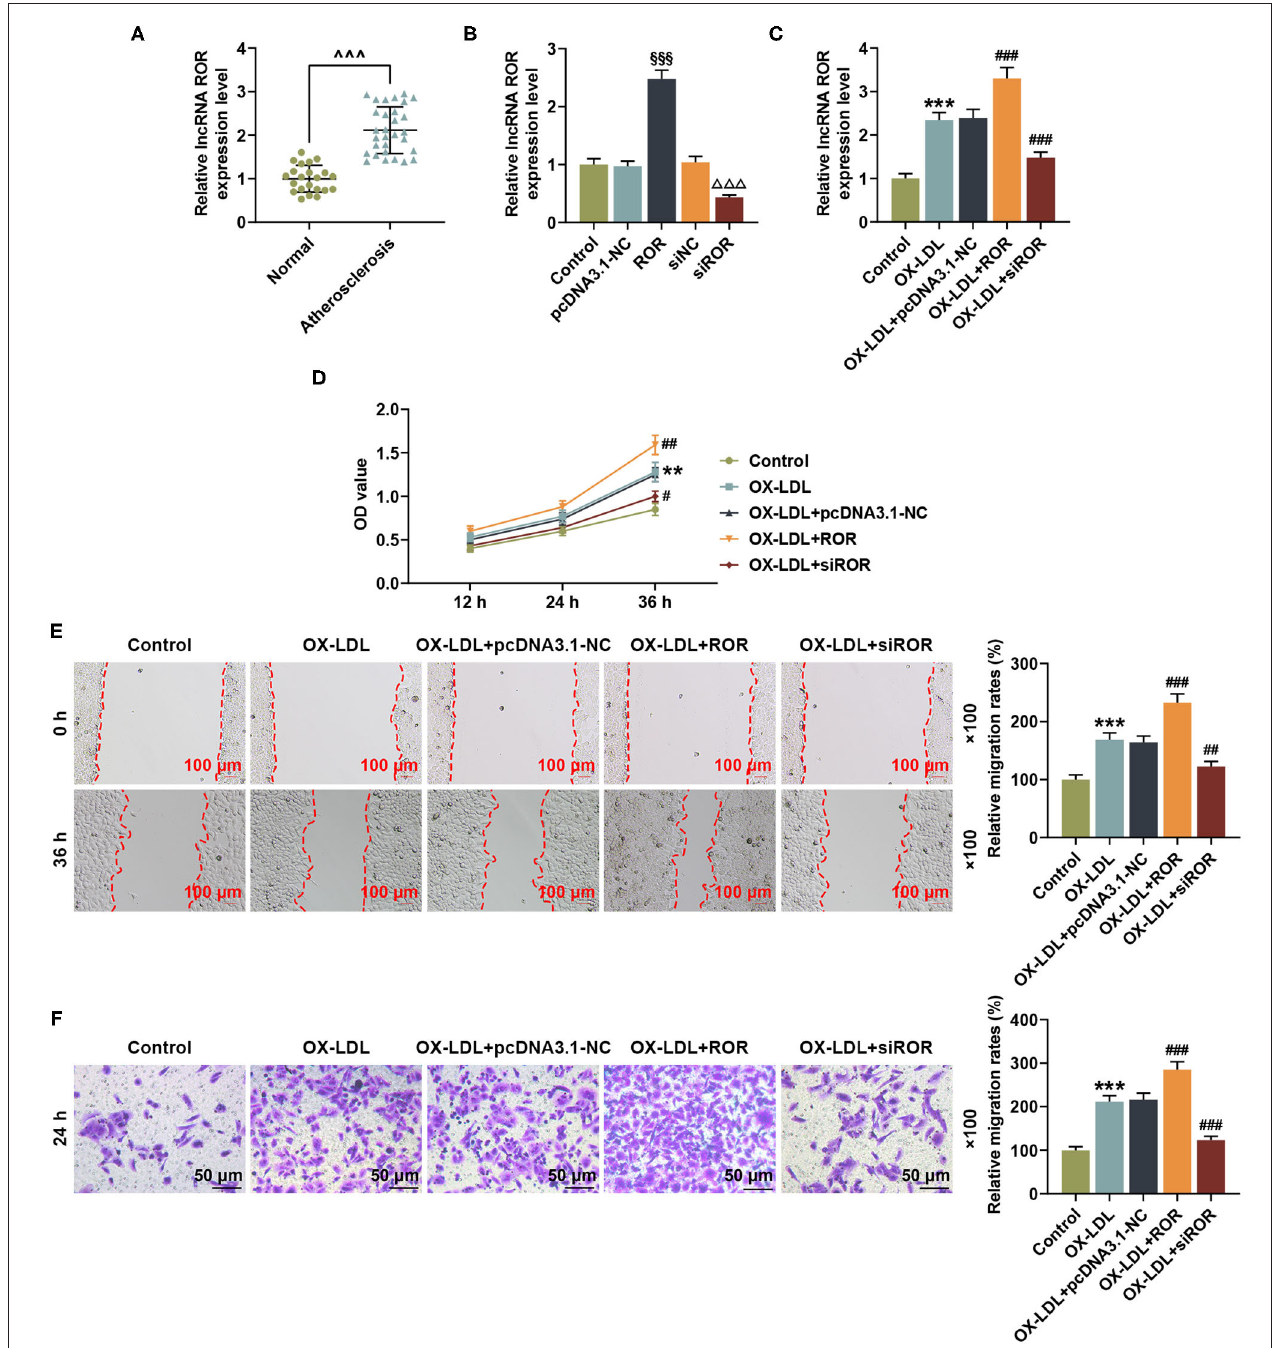
FIGURE 1 | lncRNA ROR expression was upregulated in AS and ox-LDL-treated HUVECs and affected cell viability and migration. (A) The relative lncRNA ROR expression in peripheral venous blood from patients with AS ( n = 30) and healthy donors (normal, n = 22) was measured with quantitative real-time polymerase chain reaction (qRT-PCR). β -Actin was used as an internal control. (B) Relative lncRNA ROR expression after the HUVECs were transfected with ROR overexpression plasmid, and siROR was measured by qRT-PCR. (C) Relative lncRNA ROR expression in the HUVECs after ox-LDL treatment and transfection of ROR overexpression plasmid, and siROR was measured with qRT-PCR. β -Actin was used as an internal control. (D) The viability of HUVECs after ox-LDL treatment and transfection of ROR overexpression plasmid and siROR was measured with CCK-8 assay at 12, 24, and 36h. (E) The migration of HUVECs after ox-LDL treatment and the transfection of ROR overexpression plasmid and siROR at 0 and 36h were measured with wound-healing assay. Magnification: × 100, scale bar = 100 µ m. (F) The migration of HUVECs after ox-LDL treatment and transfection of ROR overexpression plasmid, and siROR at 24h was measured with Transwell assay. Magnification: × 100, scale bar = 50 µ m. All experiments have been performed independently in triplicate, and the data were expressed as mean ± standard deviation. Statistical